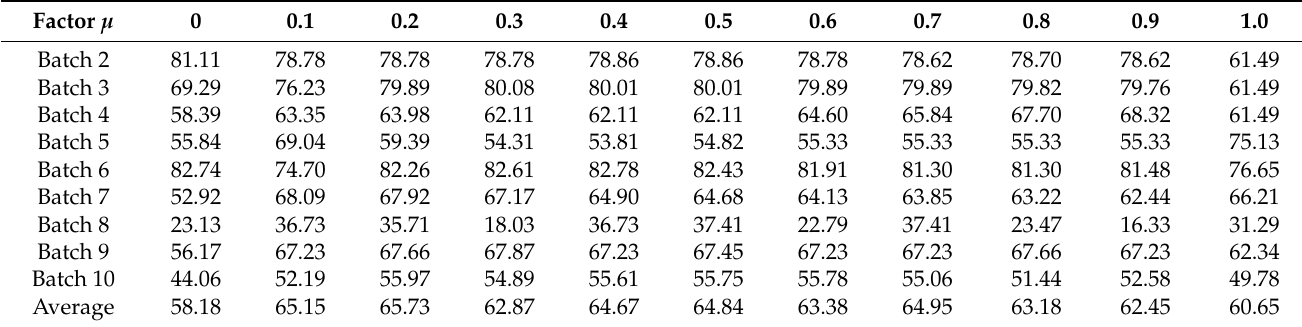
Table 2. The relationship between weighting factor and